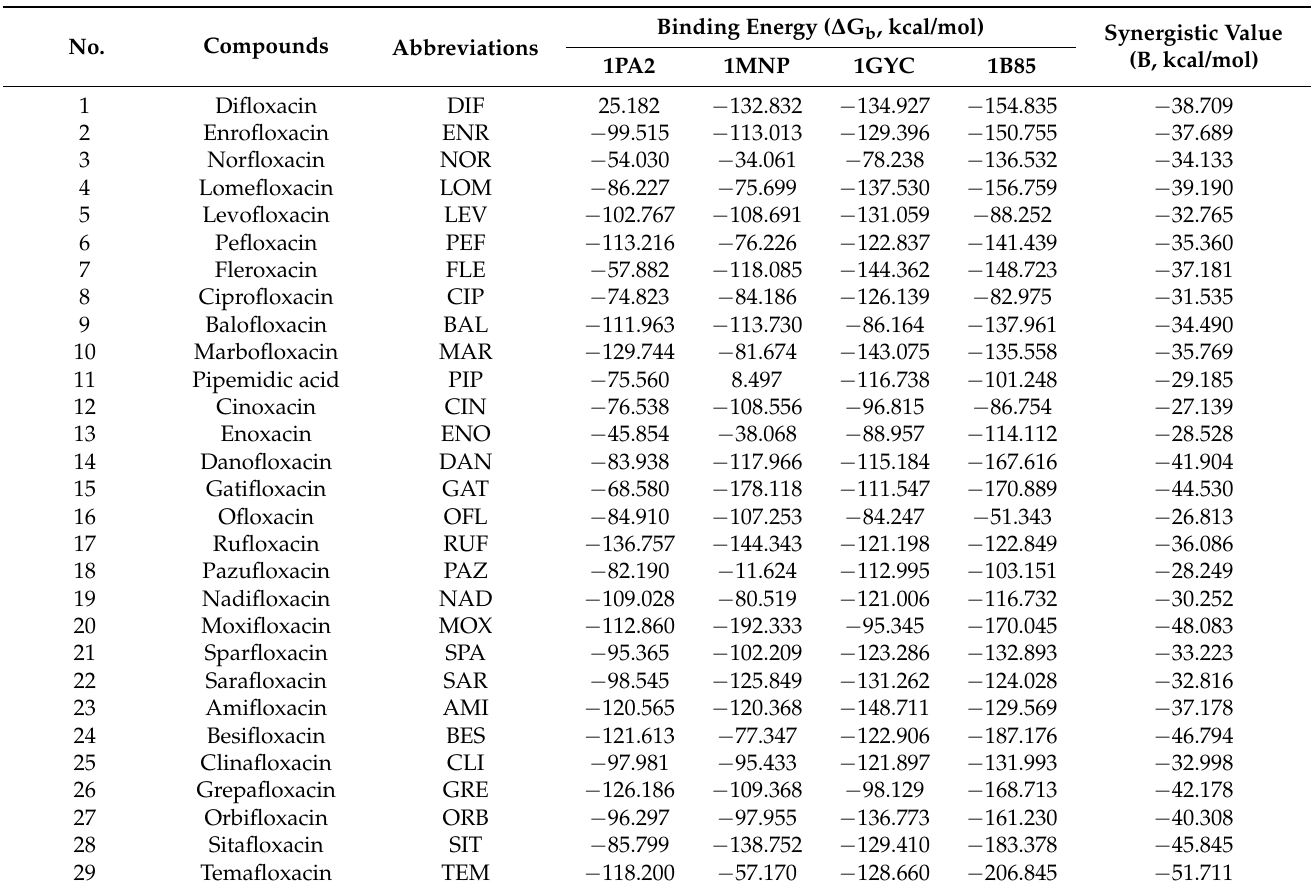
Table 1. The plant, microbial, and the plant–microbial synergistic degradation effect values of